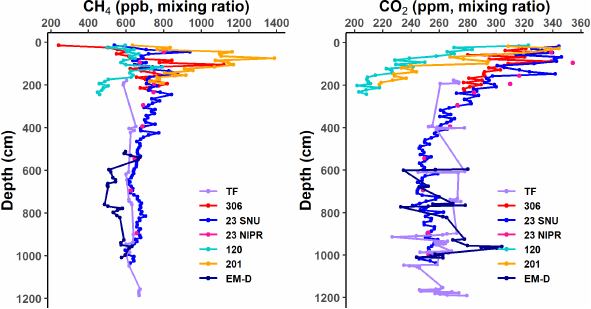
Figure A1. Vertical profiles of greenhouse gas concentrations at the Larsen BIA ice cores. (a) CH 4 records. (b) CO 2 records. CH 4 was measured using a wet-extraction method, while CO 2 was measured via both dry- and wet-extraction methods at SNU and NIPR, respectively. Results of the TF core are from Jang et al. (2017).